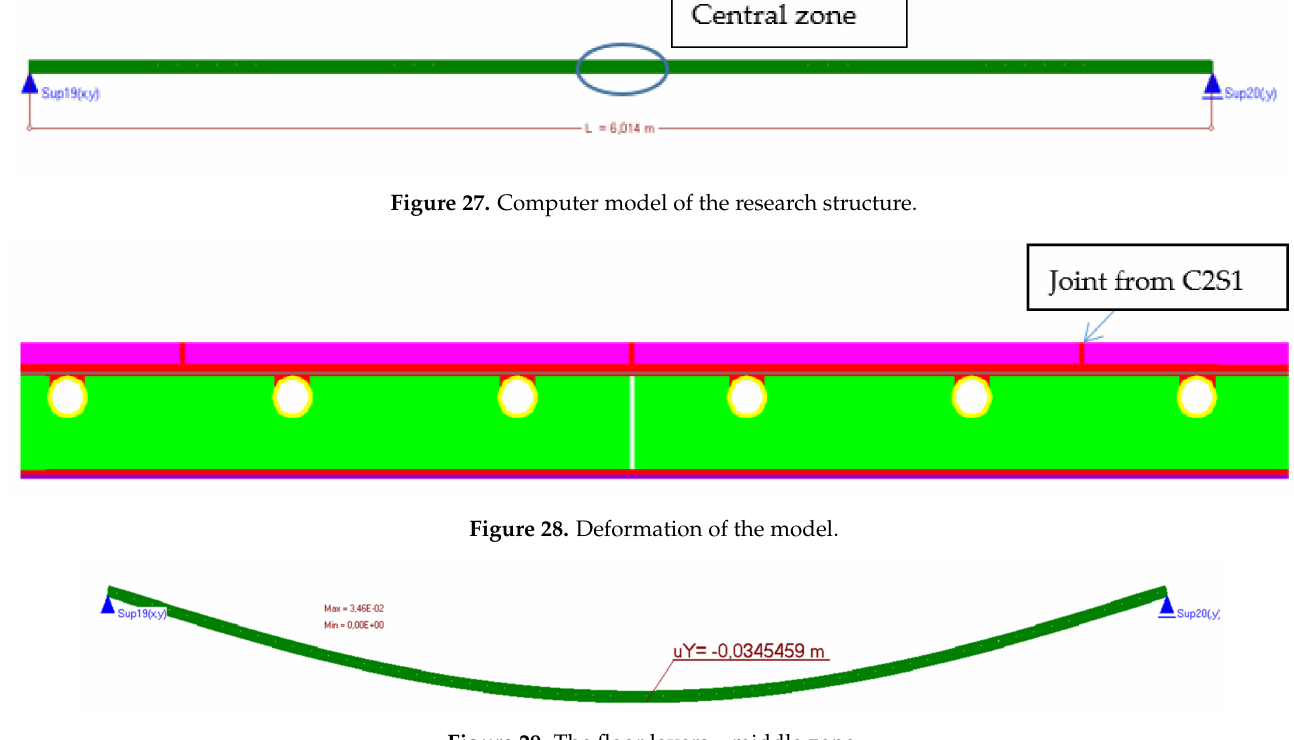
Figure 29. The floor layers—middle